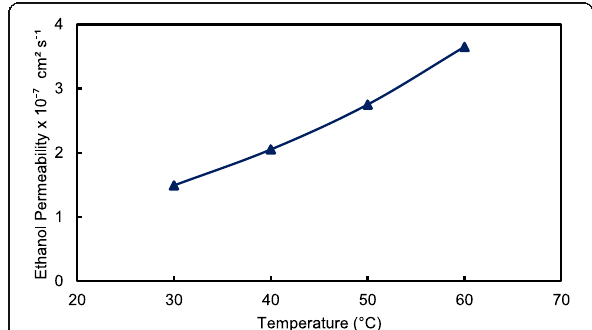
Fig. 14 Ethanol permeability of QPVA membrane and QPVA/GO composite membrane with different ethanol concentration